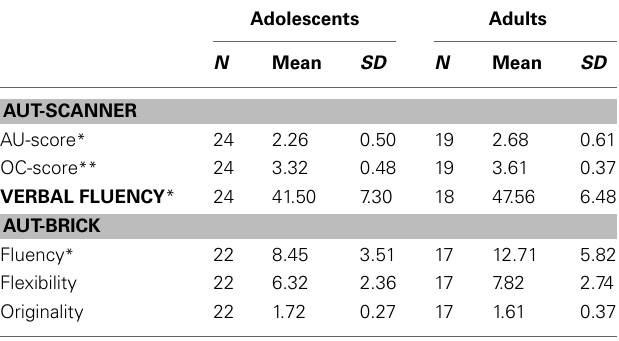
Table 1 | Age group performances.